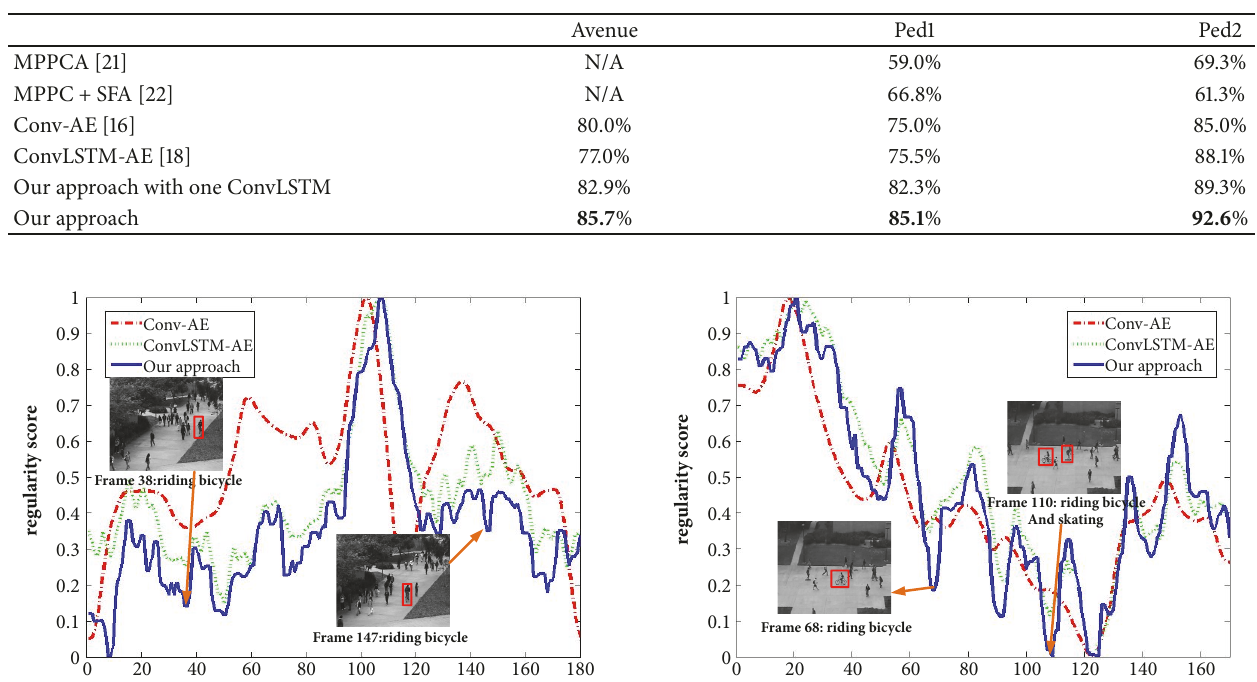
Figure 5: Illustration of pixel-level differences in the Ped2 dataset: (a) input data, (b) pixel-level differences of ConvLSTM-AE, (c) pixel-level differences of Conv-AE, and (d) pixel-level differences of our approach. Table 2: Comparisons with the state-of-the-art approaches in benchmarking datasets (frame-level AUC).